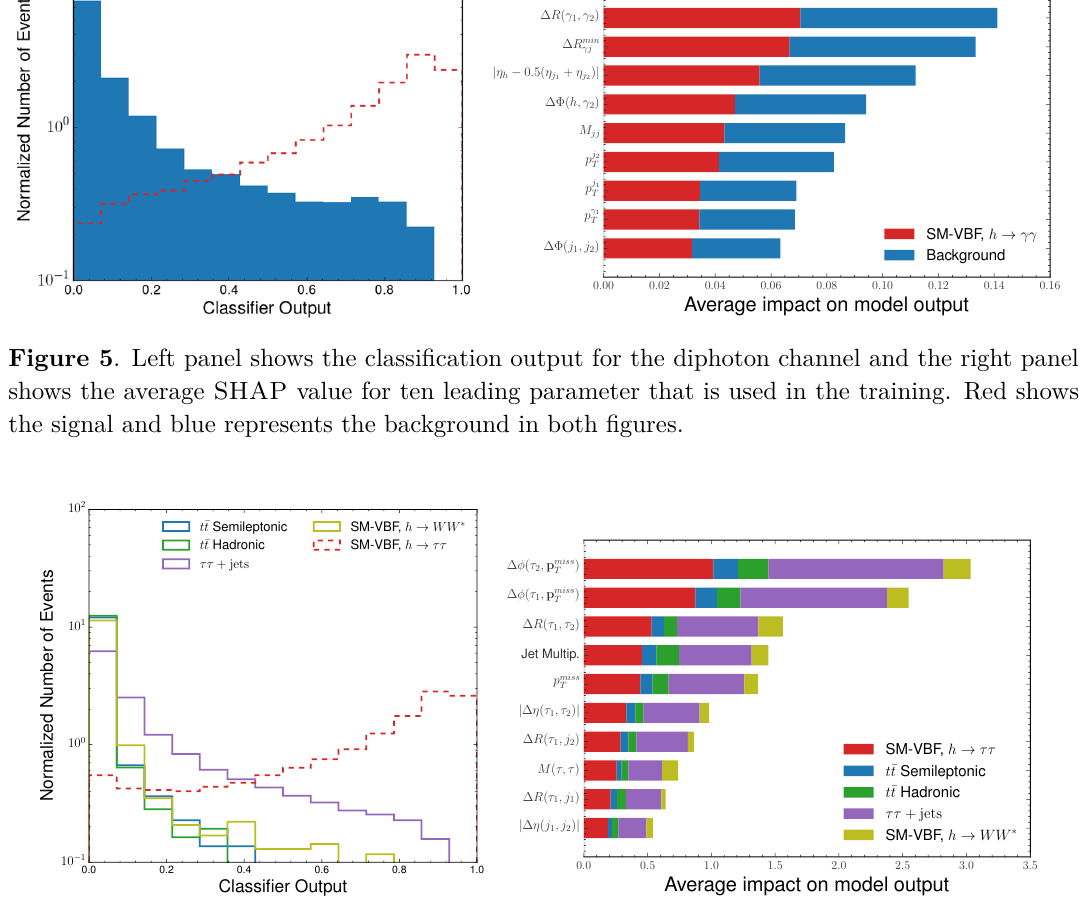
Figure 6 . Same as figure 5 for hadronic channel.